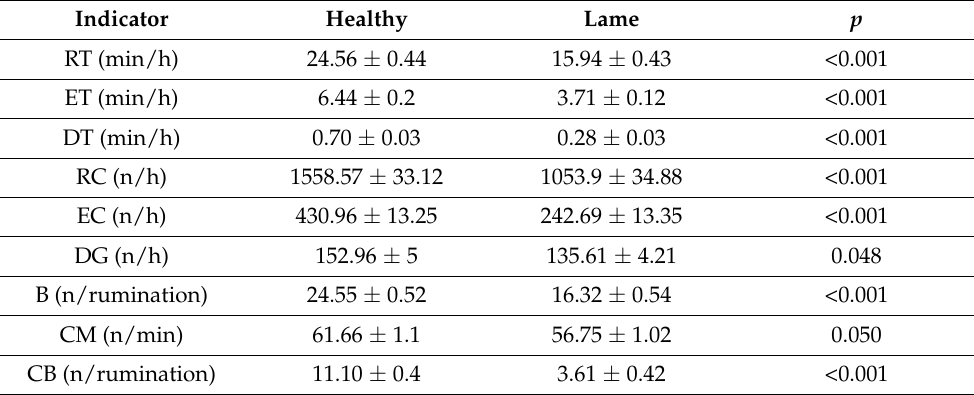
Table 3. Results of RumiWatch noseband sensor data of dairy cows that were eventually diagnosed with subclinical lameness and cows that remained healthy. Least square means (LSM) and standard deviation (SD) by groups of cows.